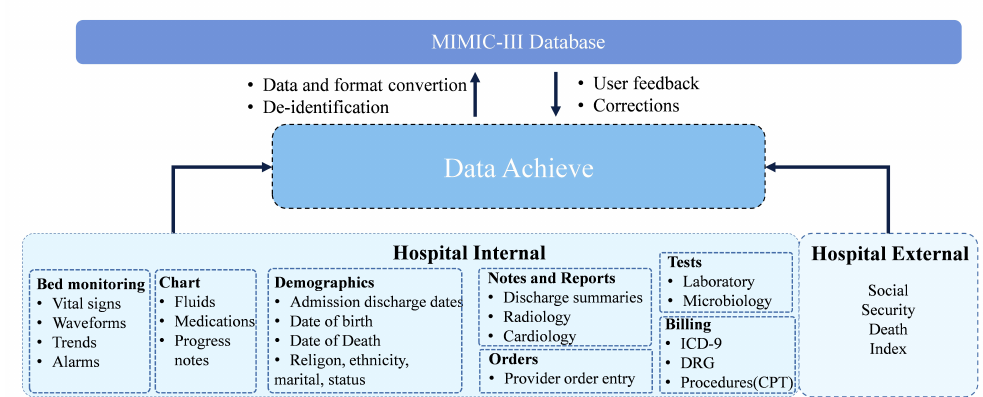
Figure 2. MIMIC-III dataset collection and dataset construction